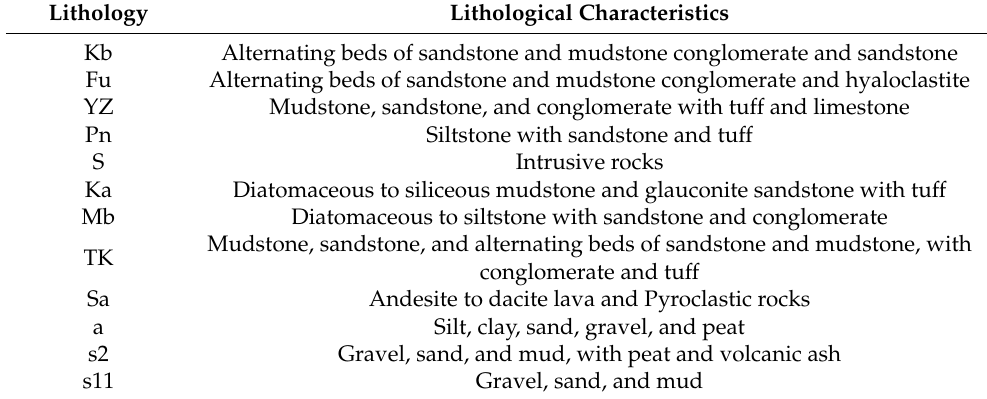
Figure 8. The distribution of slow-moving landslides before and after the earthquake with respect to lithology, distance from epicenter, slope, and topographic position index. ( a ) lithology, ( b ) distance from epicenter, ( c ) slope and ( d ) topographic position index. Table 2. Lithological parameters 1